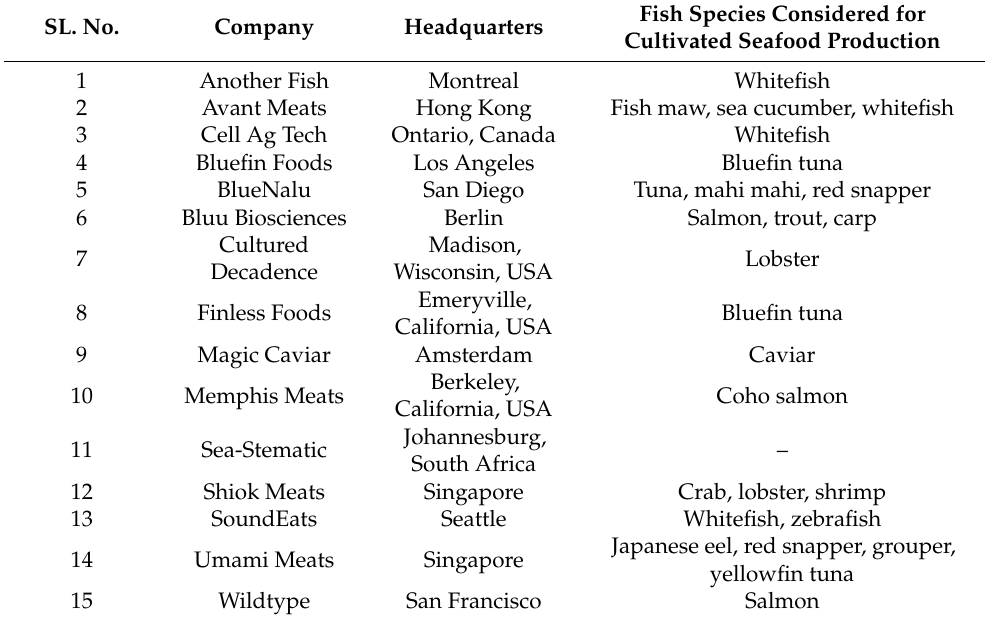
Table 2. Companies working on Cellular Aquaculture.